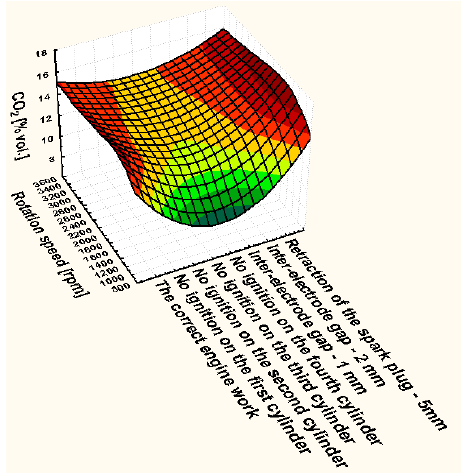
Fig. 24. The carbon dioxide content of the Fiat 1.1 petrol-powered engine